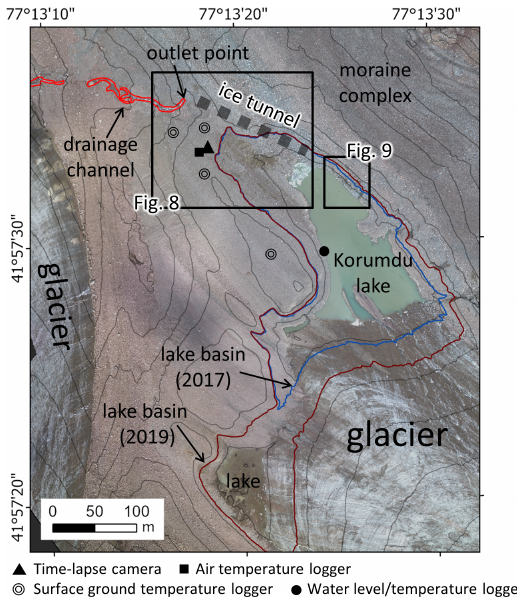
Figure 2. Overview of the Korumdu glacier front. The location of the glacier is shown in Fig. 1. Orthoimages were acquired by our UAV imagery in 2019. Contour spacing is